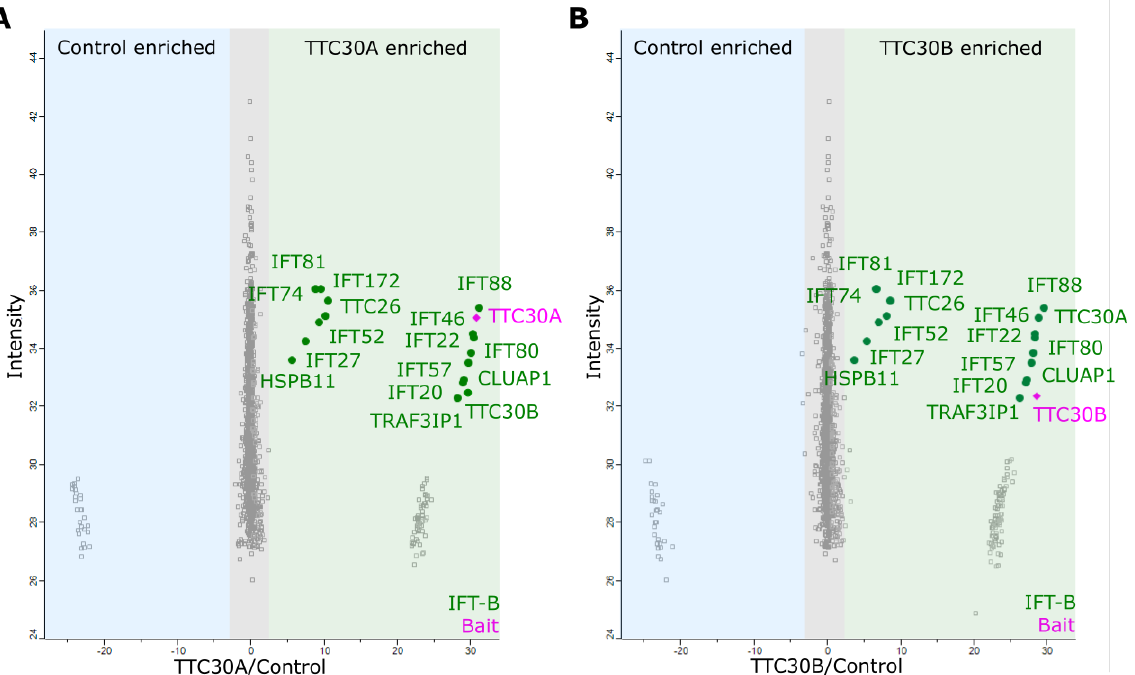
Figure 7. The scatter plots show the distribution of all proteins identified for TTC30A ( A ) as well as TTC30B ( B ). The x-axis depicts the log 2 ratios and the y-axis shows the log 2 of their respective intensities. The bait proteins TTC30A and B are shown in magenta and IFT complex B proteins in green. Proteins showing an increased binding to TTC30A/B are on the right compared to the control on the left.